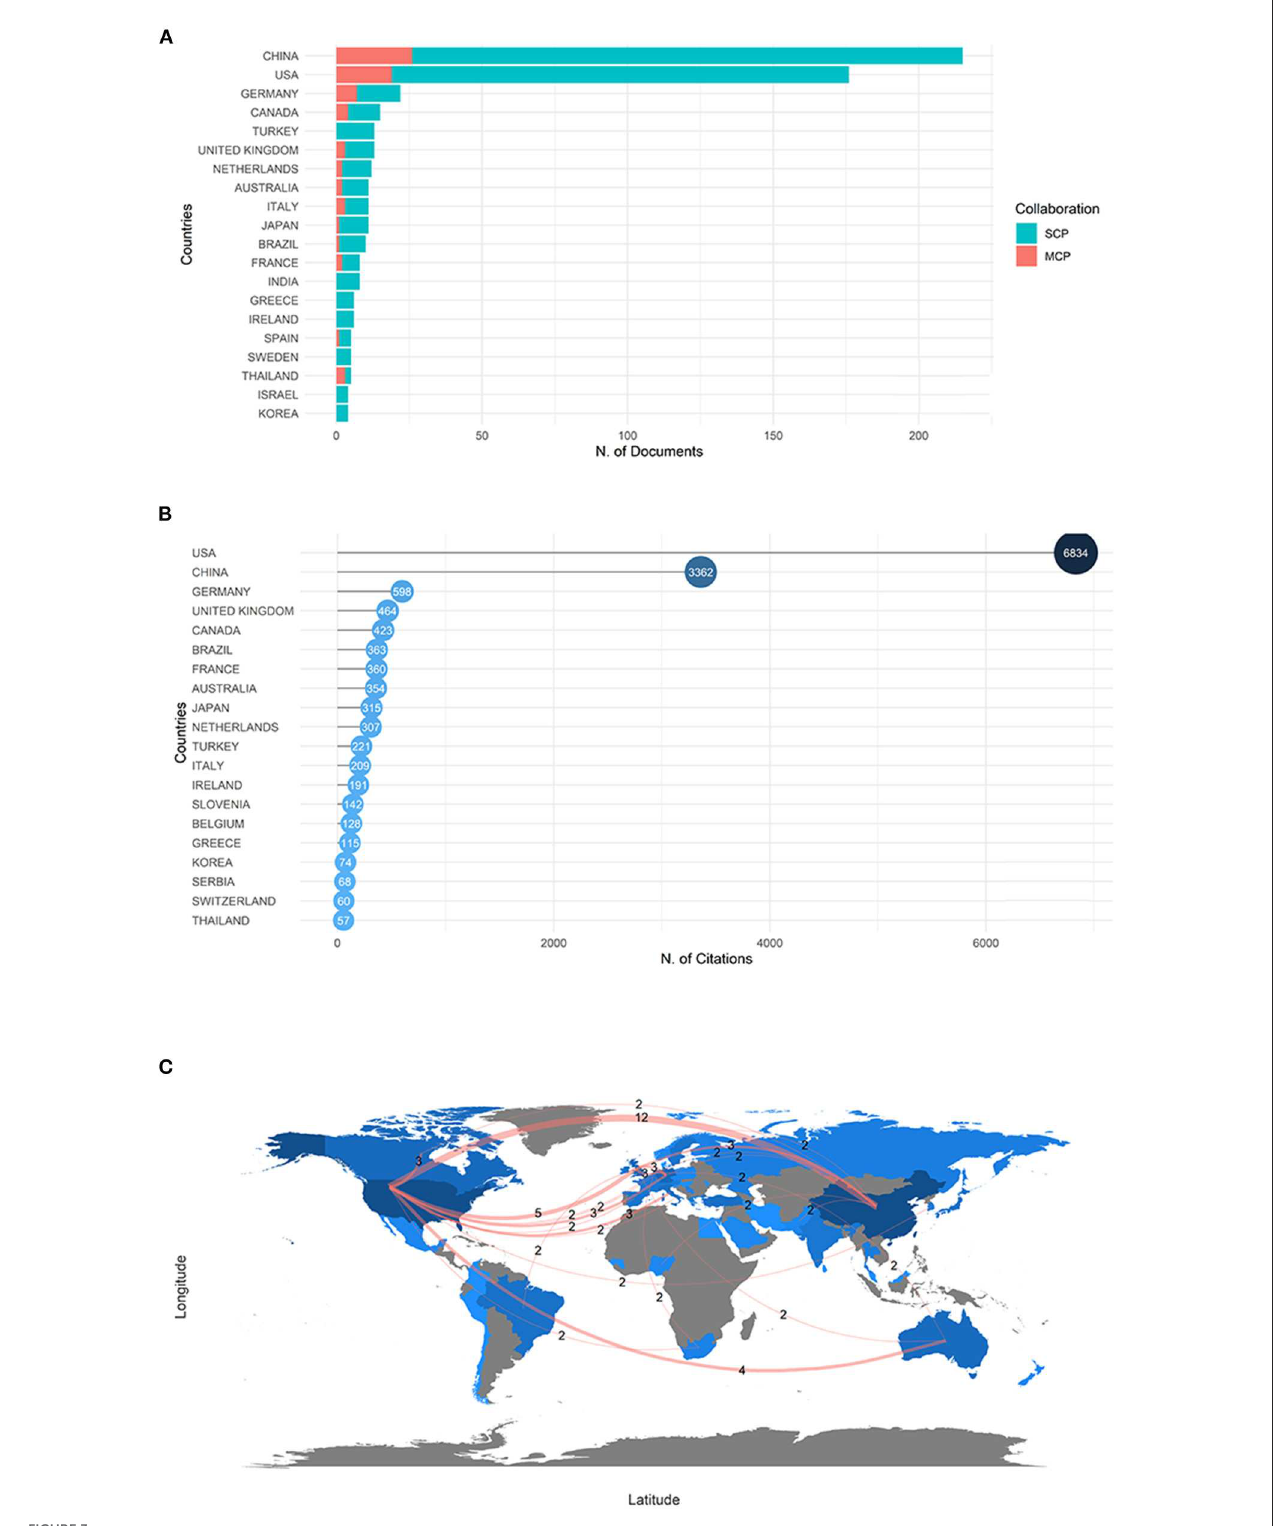
FIGURE3 (A) Top 20 countries production and collaboration histogram based on the nationality statistics of the corresponding authors in gut microbiota and trauma studies. SCP, single country publications. MCP, multiple country publications. (B) Top 20 most cited countries in gut microbiota and trauma research. (C) Country collaboration map in gut microbiota and trauma